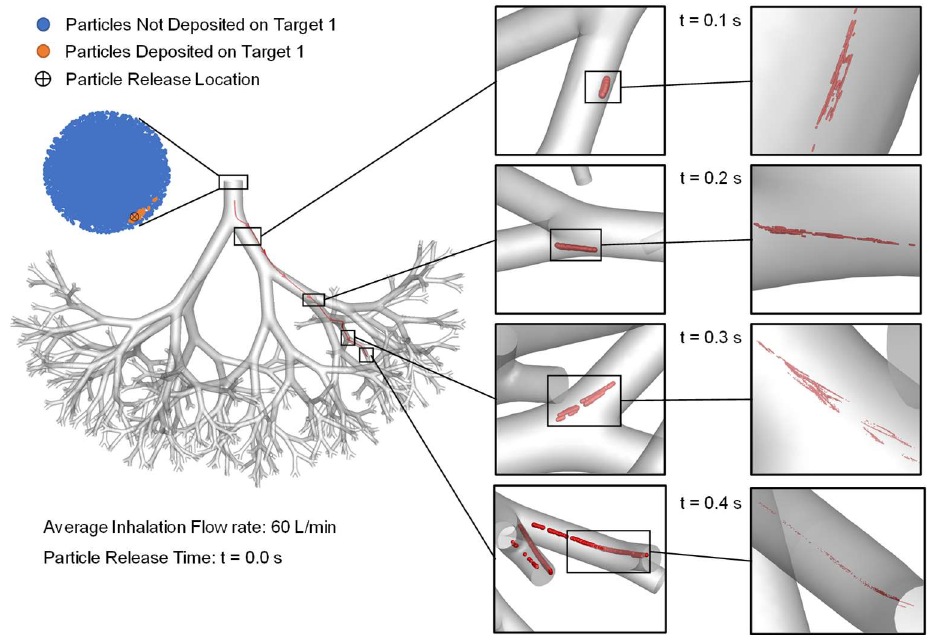
Figure 6. Particle transport dynamics for the targeted delivery simulations using the controlled particle injection method with 0.1 mm endotracheal catheter to aim for Target 1.